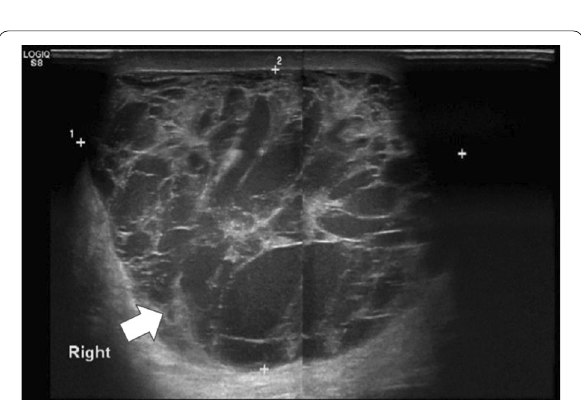
Fig. 6 USS testes 2 weeks postoperative showing right‑sided scrotal